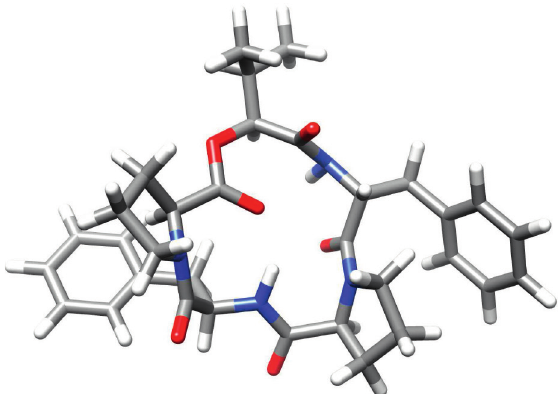
Figure 2: Optimized molecular structure of alternaramide.